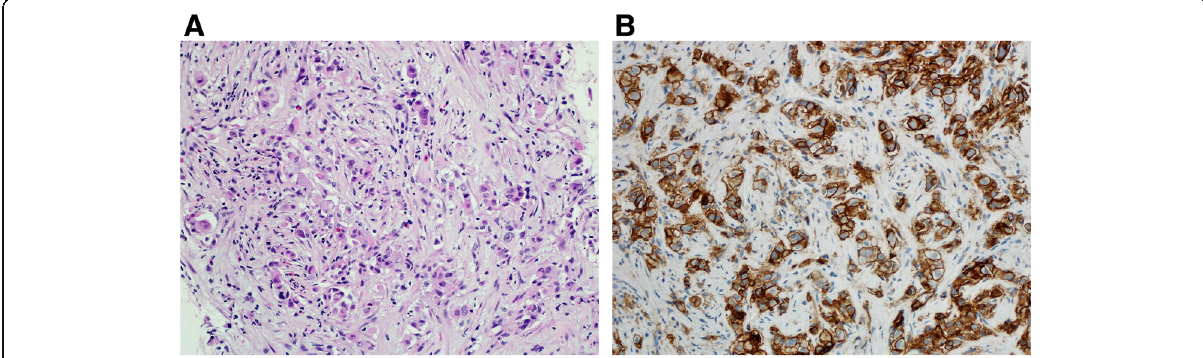
Fig. 11 A Case of metastatic pulmonary adenocarcinoma to the liver. B Immunohistochemical staining for tumor cells, moderate to intense staining (2+-3+) for PD-L1 TPS: 90 (DAKO 22C3